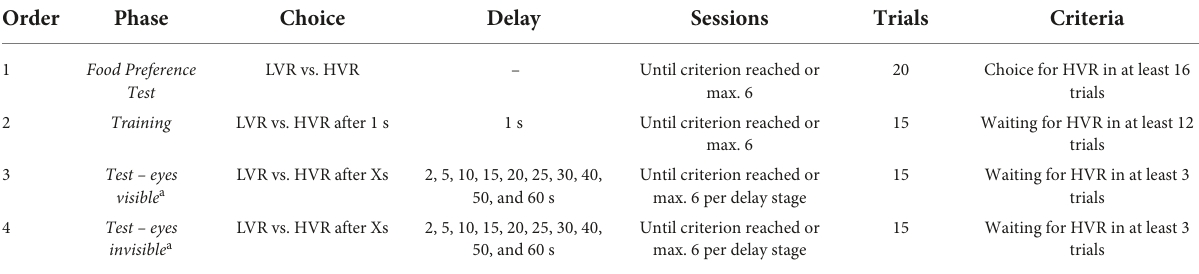
TABLE 1 Overview and order of training and test procedure (for a horse assigned to the eyes visible-first test group). Order